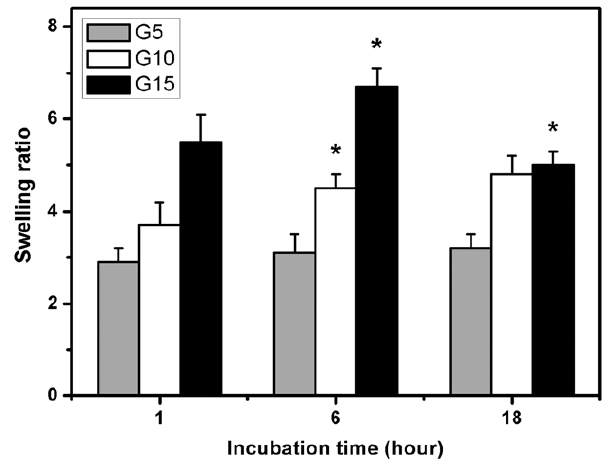
Figure 4. Swelling tests. Time course of swelling ratio of various gelatin discs after incubation in BSS at 34 u C. An asterisk indicates statistically significant differences (* P , 0.05; n =5) for the mean value of swelling ratio compared with the value at the previous time